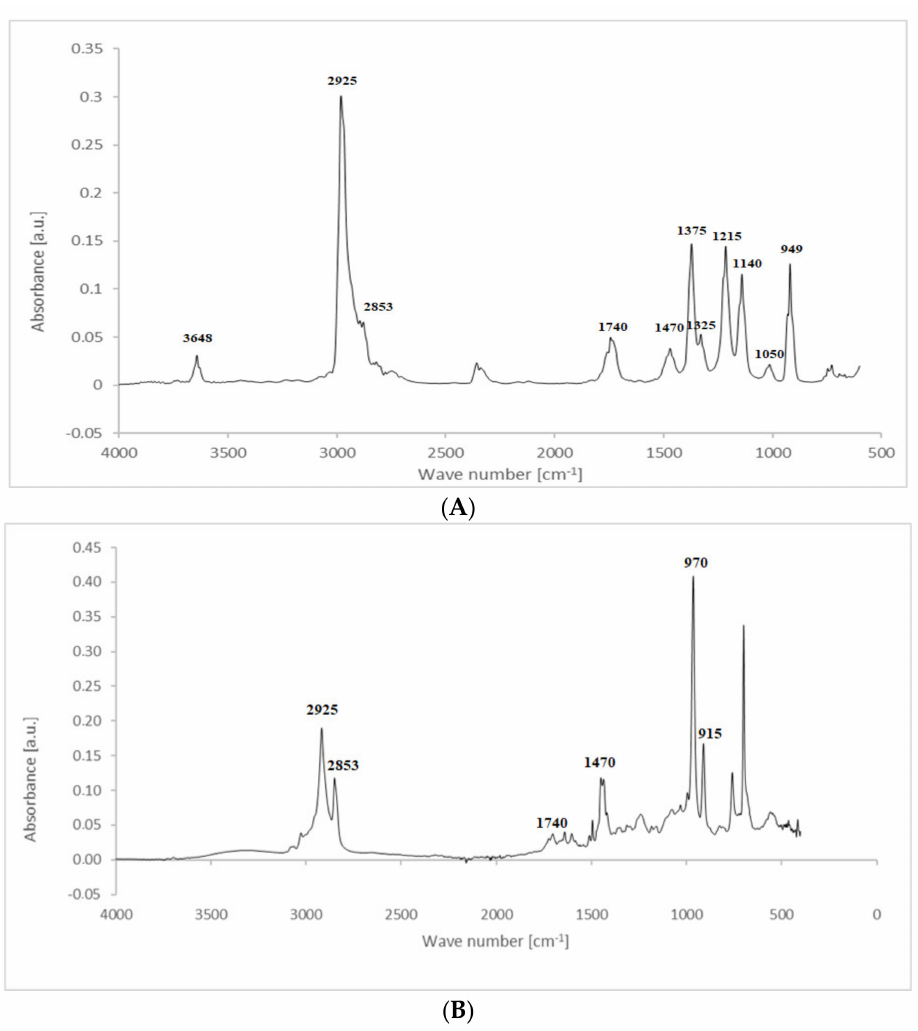
Figure 8. FTIR spectrum of SBR crosslinked with PO resin: ( A ) PO resin, ( B ) SBR_2PO. The absorption peaks at 2830 and 2745 cm − 1 , associated with CHO group